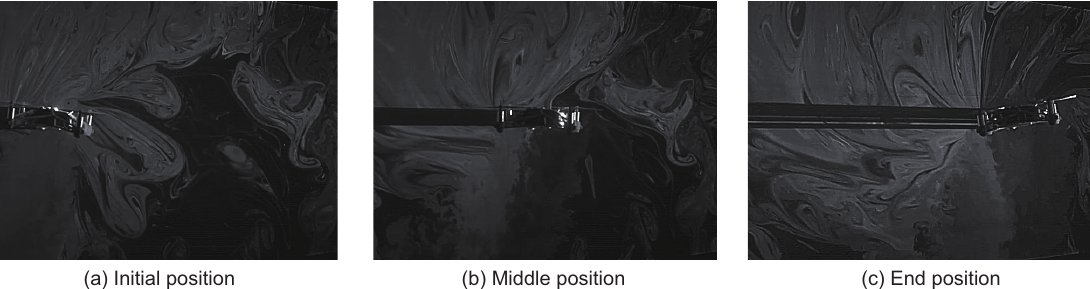
Figure 8. Snapshot of the quadcopter moving through the particles for the PIV analysis. We sent the stop command in the ( b ) position (see Supplemental Video S1a).